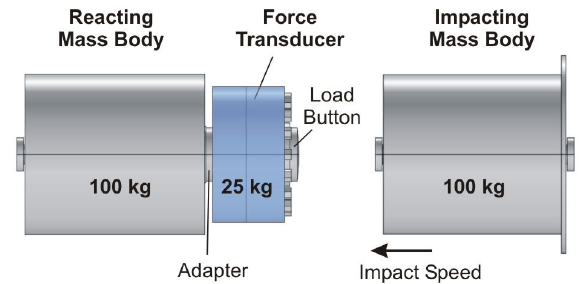
Fig. 6. Drawing of the impact configuration of the 250 kN shock force calibration device with a heavy force